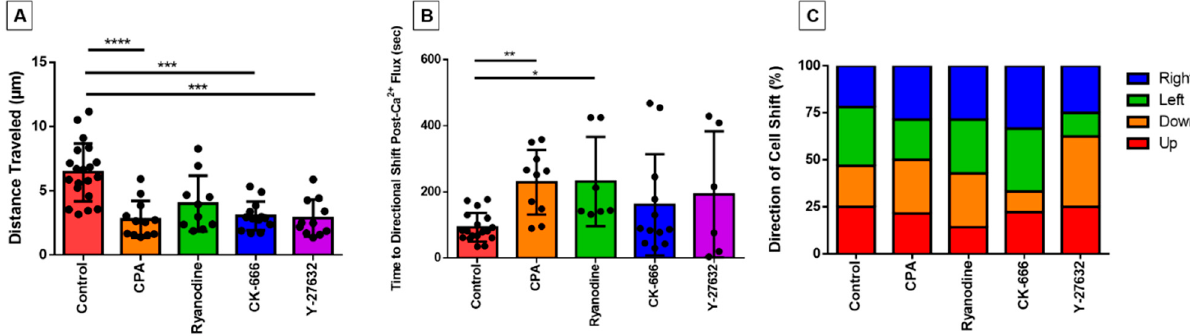
Figure 5. Evaluating eosinophil motility response and its relationship with the PICR. ( A ) The centroid of analyzed eosinophils was tracked over the course of the experiment to determine the total distance traveled ( µ m) for control and treated (CPA, ryanodine, CK-666, and Y-27632) eosinophils. (*** p < 0.001; **** p < 0.0001) ( B ) A number of eosinophils changed their direction of movement subsequent to the calcium flash. The time in between the events was measured across treated eosinophils and compared with control eosinophils (* p < 0.05; ** p < 0.01; p = 0.008, Kruskal–Wallis test). ( C ) Percentage of cells in each group that altered their movement path towards one of four different directions (perfusion moves from left to right in the field of view (FOV)).